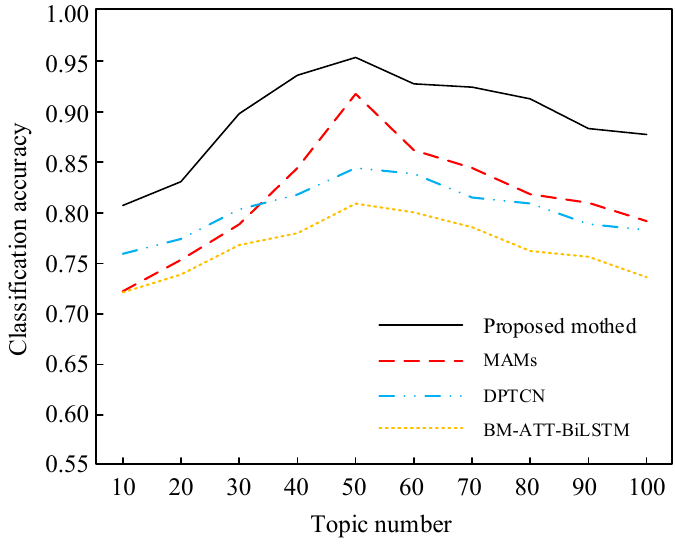
Figure 8. TC accuracy of different methods under SCP dataset.